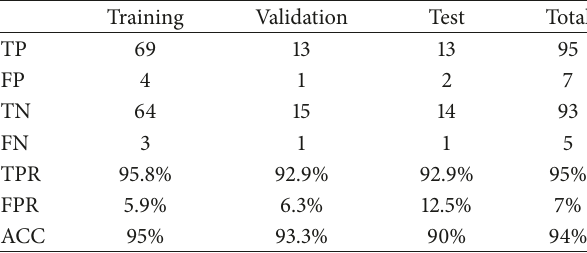
Table 2: Classification results for different